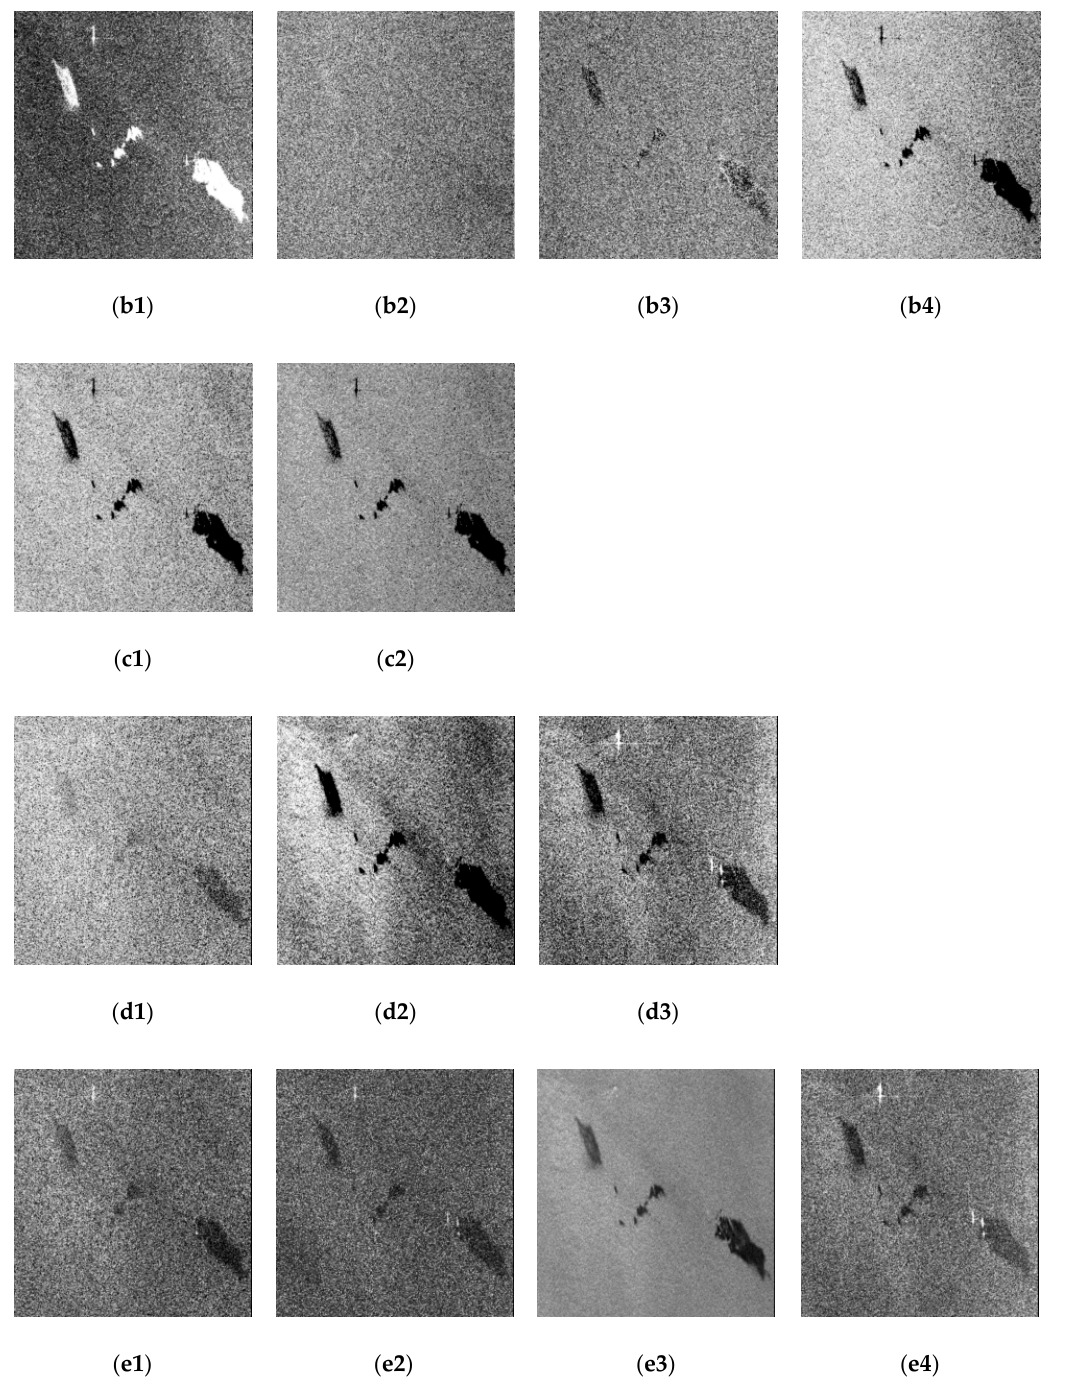
Figure 7. All the polarized features extracted from Radarsat2 data. ( a1 – a3 ) H / A / Alpha decomposition, a1 for entropy, a2 for anisotropy, a3 for alpha. ( b1 – b4 ) H / A / Alpha decomposition and Single-Bounce Eigenvalue Relative Di ff erence (SERD), b1 for entropy, b2 for anisotropy, b3 for alpha, b4 for SERD. ( c1 , c2 ) Scattering coe ffi cients calculated from scattering matrix, c1 for co-polarized correlation coe ffi cients, c2 for conformity coe ffi cients. ( d1 – d3 ) Freeman 3-component decomposition, d1 for double-bounce scattering, d2 for rough surface scattering, d3 for volume scattering. ( e1 – e4 ) Yamaguchi 4-component decomposition, e1 for double-bounce scattering, e2 for helix scattering, e3 for rough surface scattering, e4 for volume scattering.